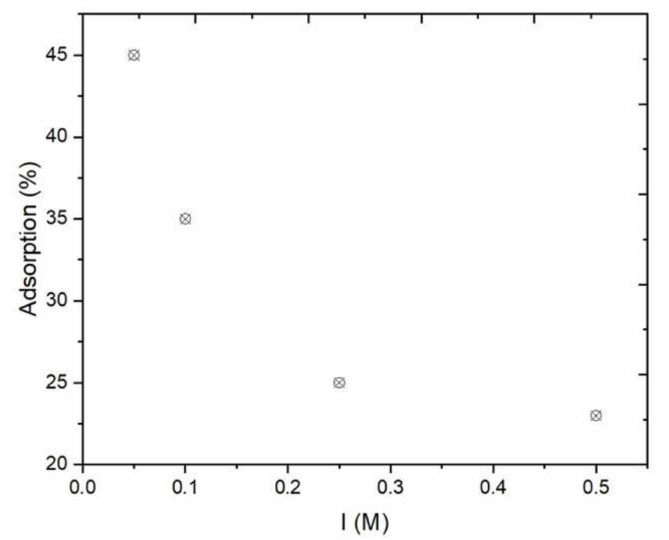
Figure 5. E ff ect of solution ionic strength on the Cr(VI) adsorption process. Aqueous phase: 0.01 g / L Cr(VI) at pH 3. Carbon dosage: 0.5 g / L. Temperature: 20 ◦ C. Time: 5 h. Stirring speed: 1000 min − 1 .